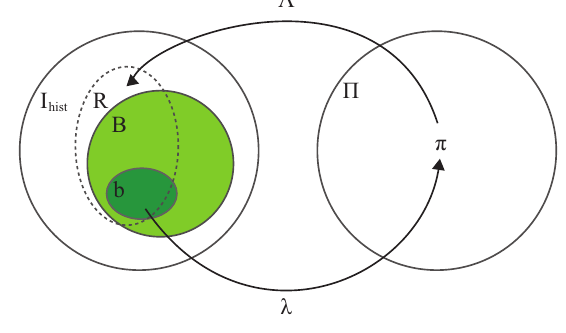
Figure 1. The LFD process. The light-colored area represents the wanted behavior B which is demonstrated with N training demonstrations b (cid:8) η (1) ,...,η ( N ) (cid:9) ⊂ B represented by the dark-colored area. = The learning function λ creates a controller π ∈